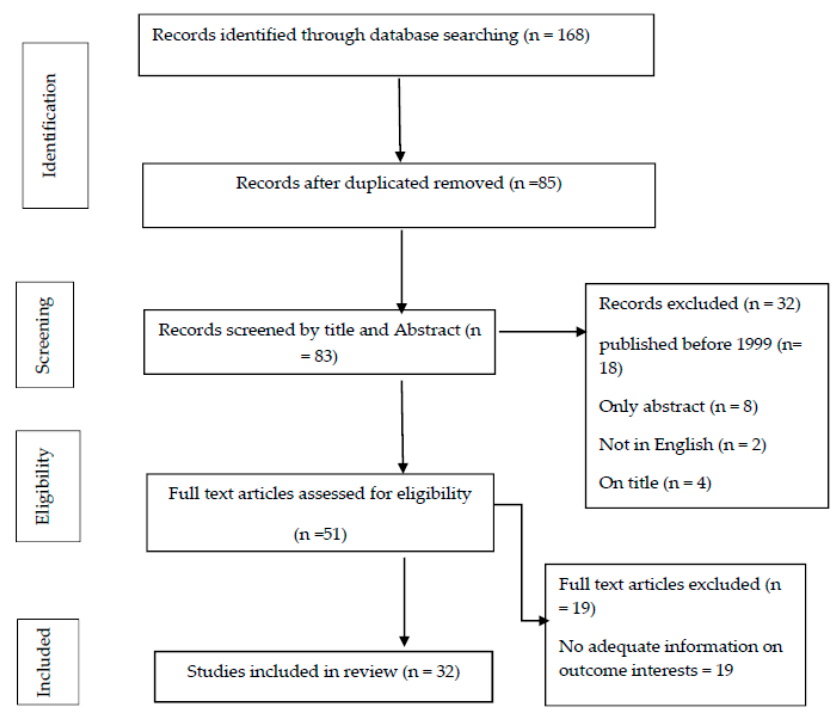
Figure 1. Literature search flowchart with eligibility criteria. Table 1. Summary of results for the application of telemedicine in different medical examinations/tests.